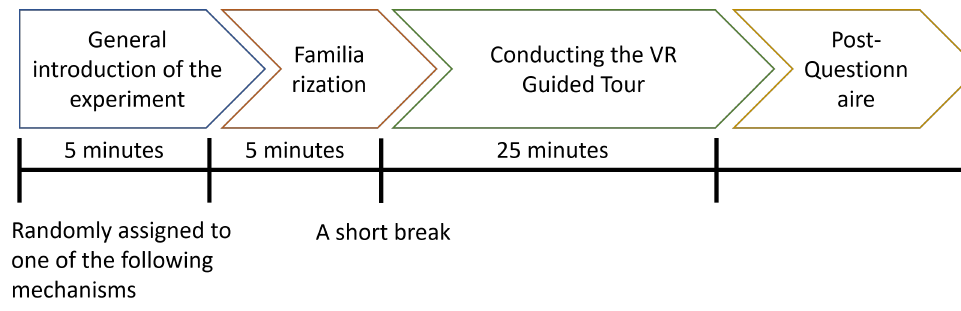
Figure 4. The experimental